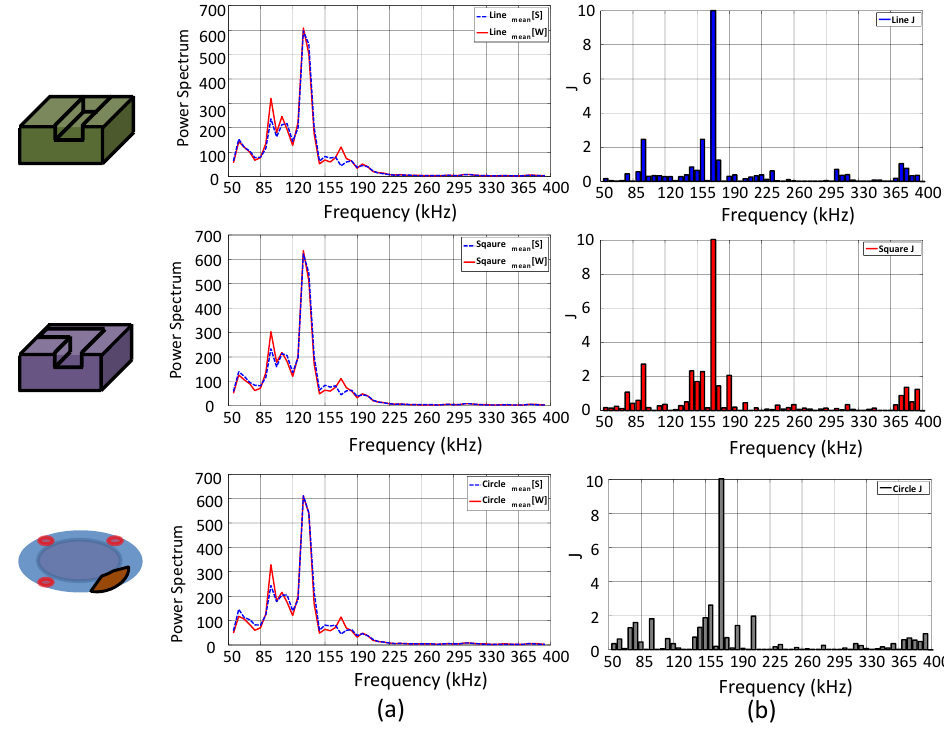
Figure 12. Frequency domain AE signal and classification index for sharp and worn tools: ( a ) fre- quency domain signals; ( b ) classification index J (6 kHz).